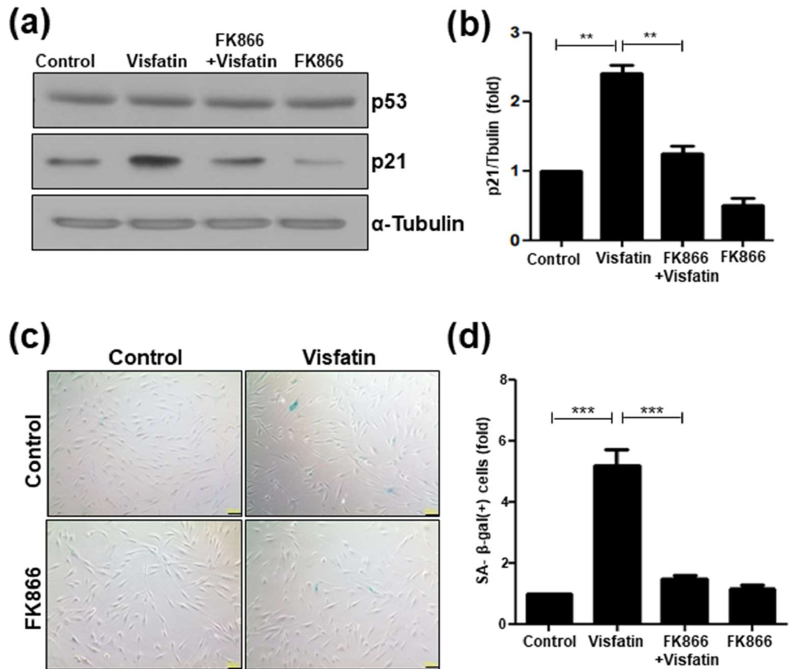
Figure 5. FK866 impedes the visfatin-induced senescence of human dental pulp cells (hDPCs). hDPCs were pretreated with FK866 (10 µ M) for 2 h and then incubated with visfatin (500 ng / mL) for 24 h. ( a ) Cell extracts were subjected to Western blotting to detect p53 and p21 proteins. α -Tubulin was used as the loading control. ( b ) Densitometric analysis for assessing relative p21 protein levels were normalized to α -Tubulin protein levels. ( c ) Representative image of senescence-associated (SA)- β -galactosidase staining. Scale bar: 200 µ m. ( d ) Quantification of the percentage of SA- β -galactosidase-positive cells. ** p < 0.01, *** p < 0.001.